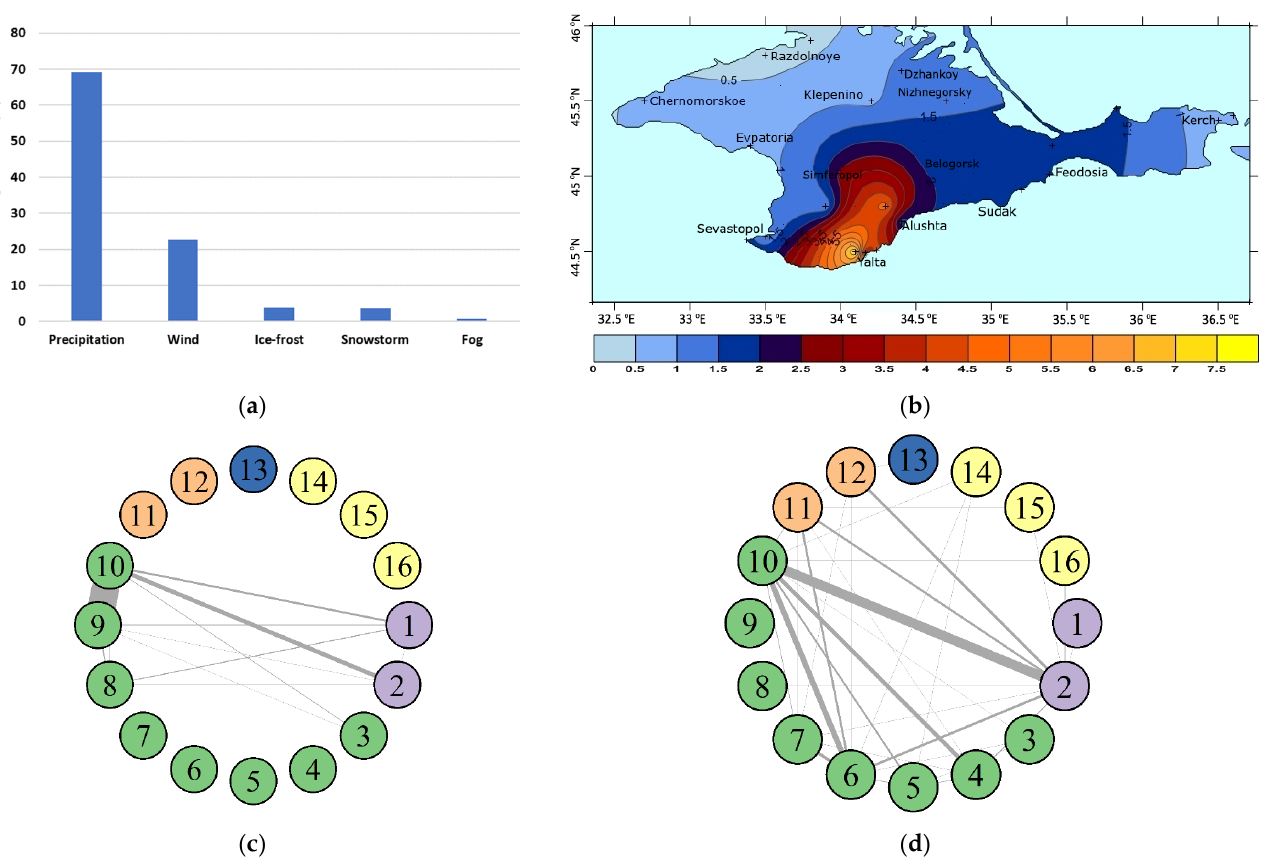
Figure 2. Distribution of the number of cases of SWP by groups of SWP types ( a ), by the space of the Crimean region ( b ), graphs of combinations of SWP types of the warm ( c ) and cold ( d ) half-year according to data for the period 1976–2020. The color of the graphs corresponds to the SWP groups as follows: green—the “precipitation” group, purple—“wind”, yellow—“icy frost”, brown—“blizzard”, blue—“fog”. The numbers on the graphs correspond to the type of SWP as follows: 1—squall,